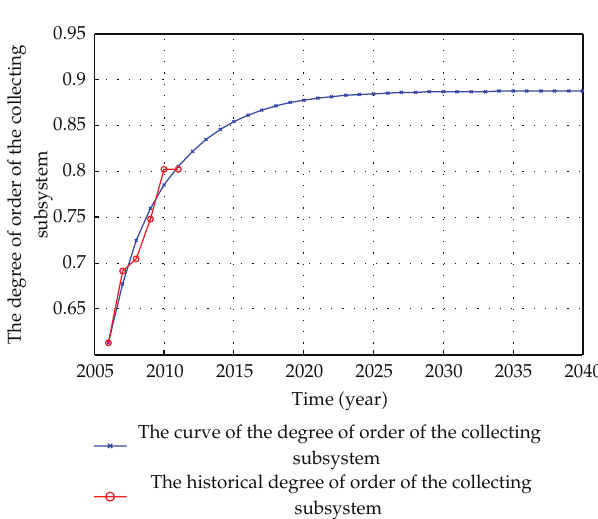
Figure 2: The synergy evolution curve of the degree of order of the collecting subsystem.